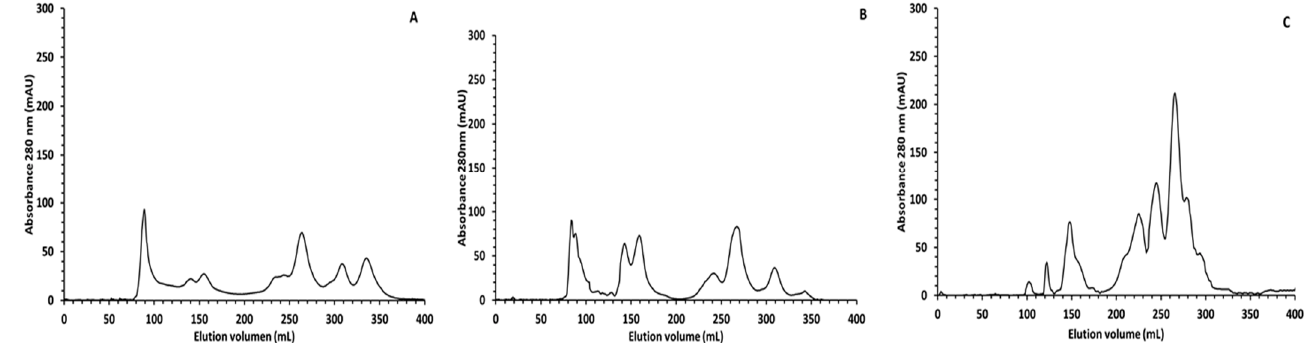
Figure 2. Size exclusion chromatography profile of protein and peptides after different phases of digestion of the whey-beverage ( Colada ). ( A ) Oral phase, ( B ) gastric phase, ( C ) intestinal phase (complete digestion).